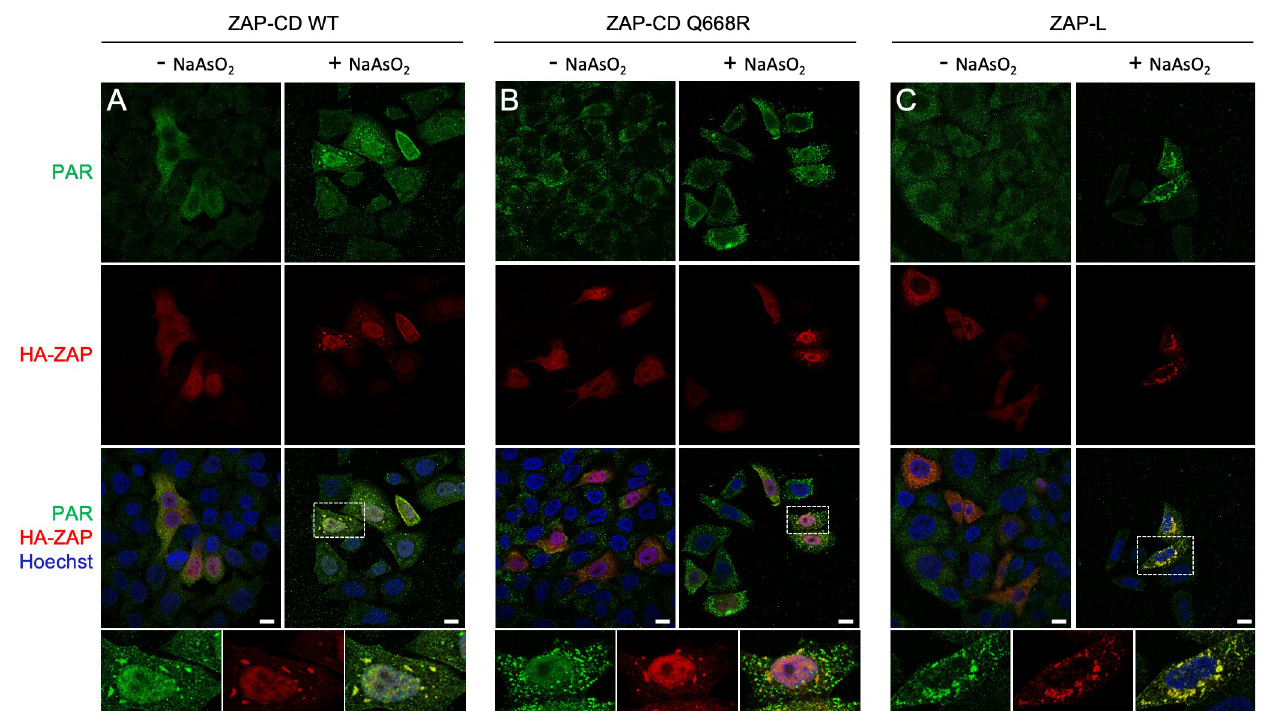
Fig 7. ZAP redistributes with PAR in cytoplasmic puncta. HeLa cells were transiently transfected with (A) vector encoding HA-tagged ZAP-CD, (B) ZAP-CD Q668R mutant, or (C) ZAP-L. Twenty-four hours later, cells were treated with sodium arsenite or mock-treated, fixed, immunostained with anti- HA and anti-PAR primary antibodies followed by dye-conjugated secondary antibodies, and imaged by using fluorescence microscopy. Results are representative of three (ZAP-CD) or two (ZAP-L) independent experiments. Scale bars, 10 μ m.